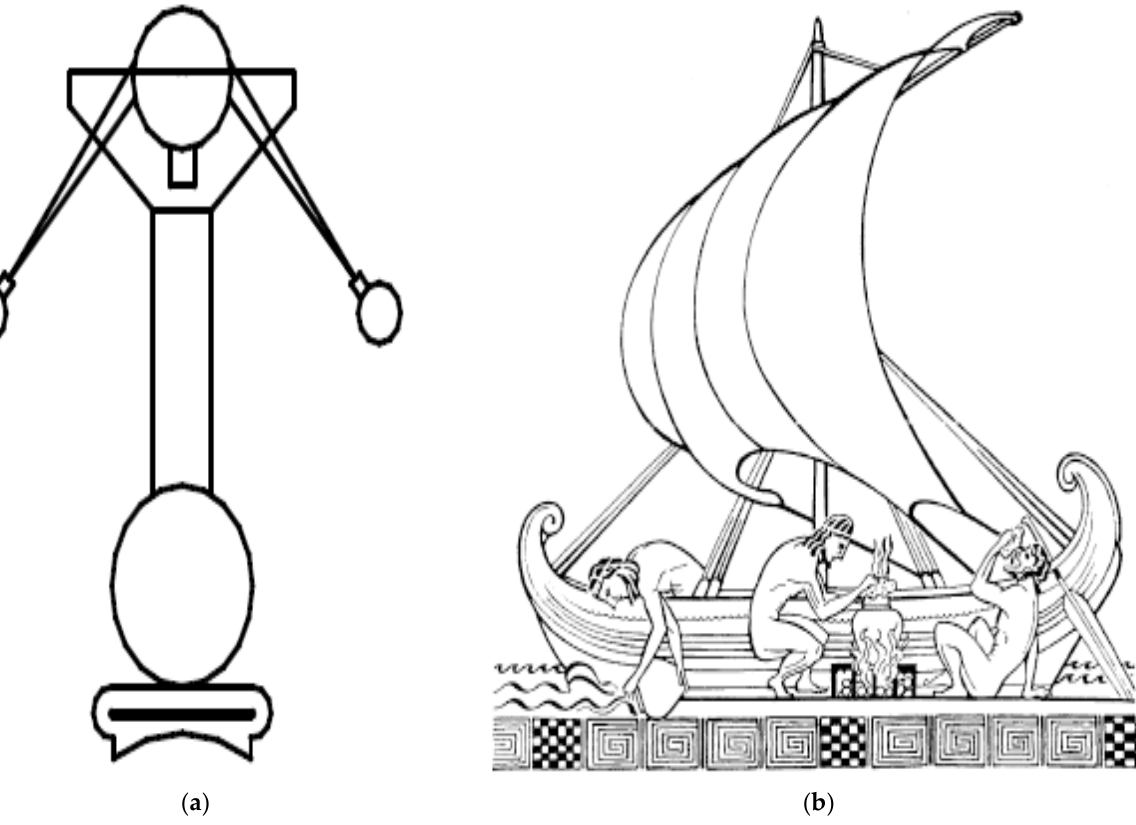
Figure 3. Desalination in devices in the Hellenistic period: ( a ) Cleopatra’s alembic and ( b ) sailors producing freshwater with seawater distillation [6].